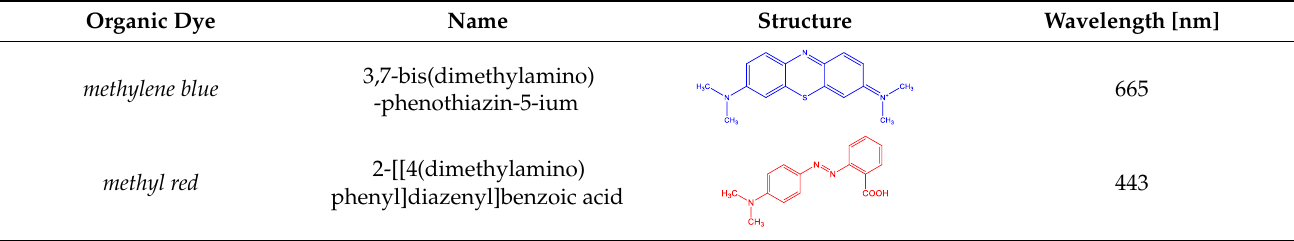
Table 1. Characteristics of the organic dyes used.